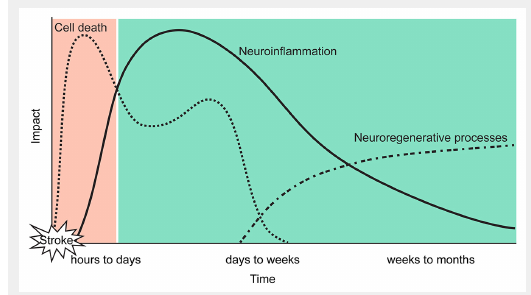
Multiphasic brain interactions after stroke and opportunities for treatment. Previous neuroprotective strategies targeted pathological mechanisms in a very narrow window of opportunity in the (hyper-) acute phase after stroke (orange). Recently, the focus of translational stroke research has shifted towards understanding pathological processes in the subacute and chronic phase such as neuroinflammation and neuroregeneration (green). These targets have the potential for novel therapeutic approaches which are suitable for a larger population of stroke patients then neuroprotective agents or